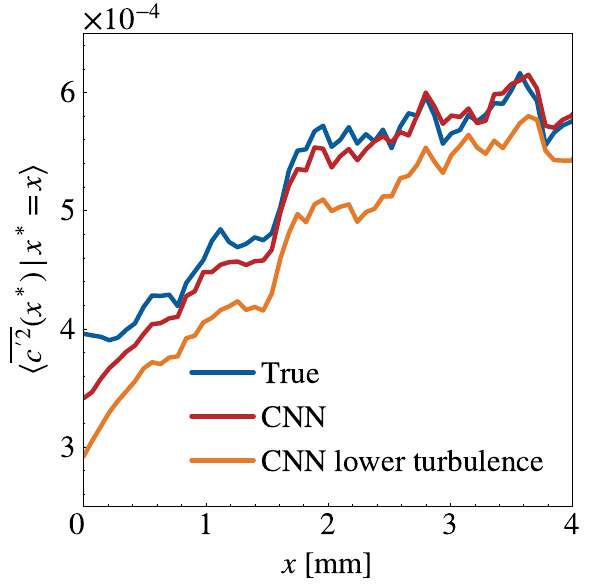
Figure 11. Evolution of transverse averages of the true c (cid:48) 2 and both CNN predictions in the first 4mm of the R2 flame.